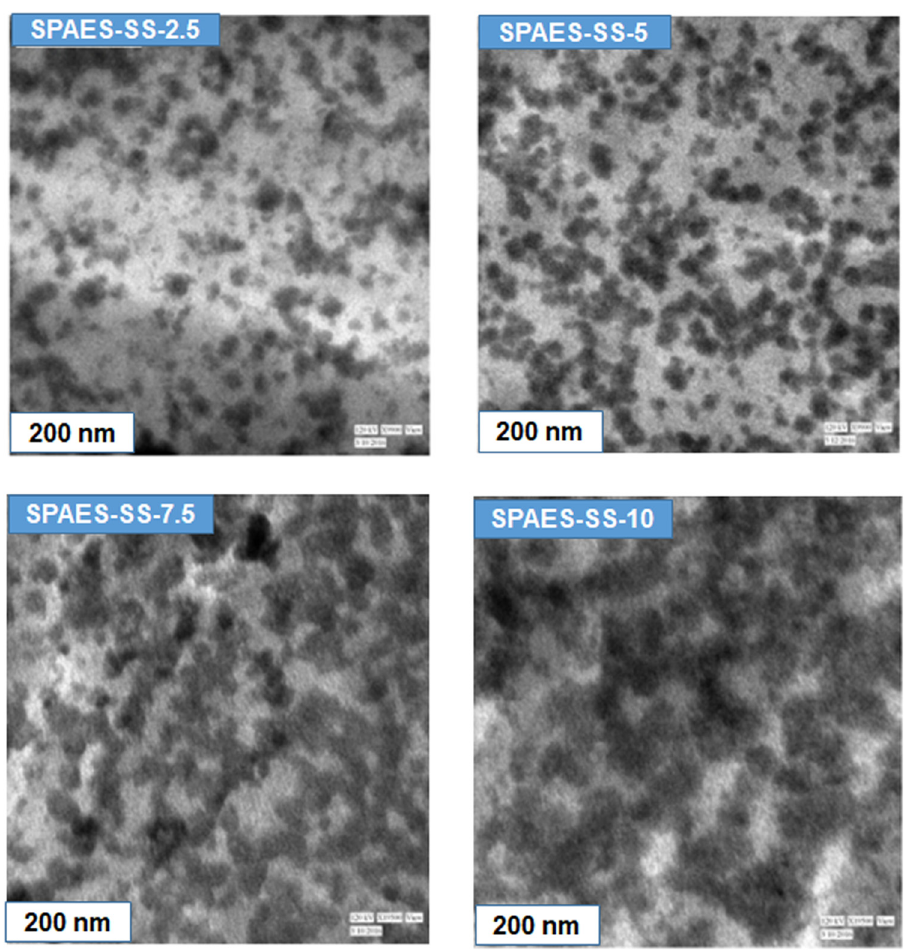
Figure 9: TEM micrographs of lead ( Pb 2 + ) stained SPAES - SS - X composite membranes. ( THSPSA ) into the polymer matrix reduced the distance compared to the pristine TPQSH - COOH - 50 membrane. It between two neighboring proton - conducting moieties, facilitated the surface transportation e ff ectively through the